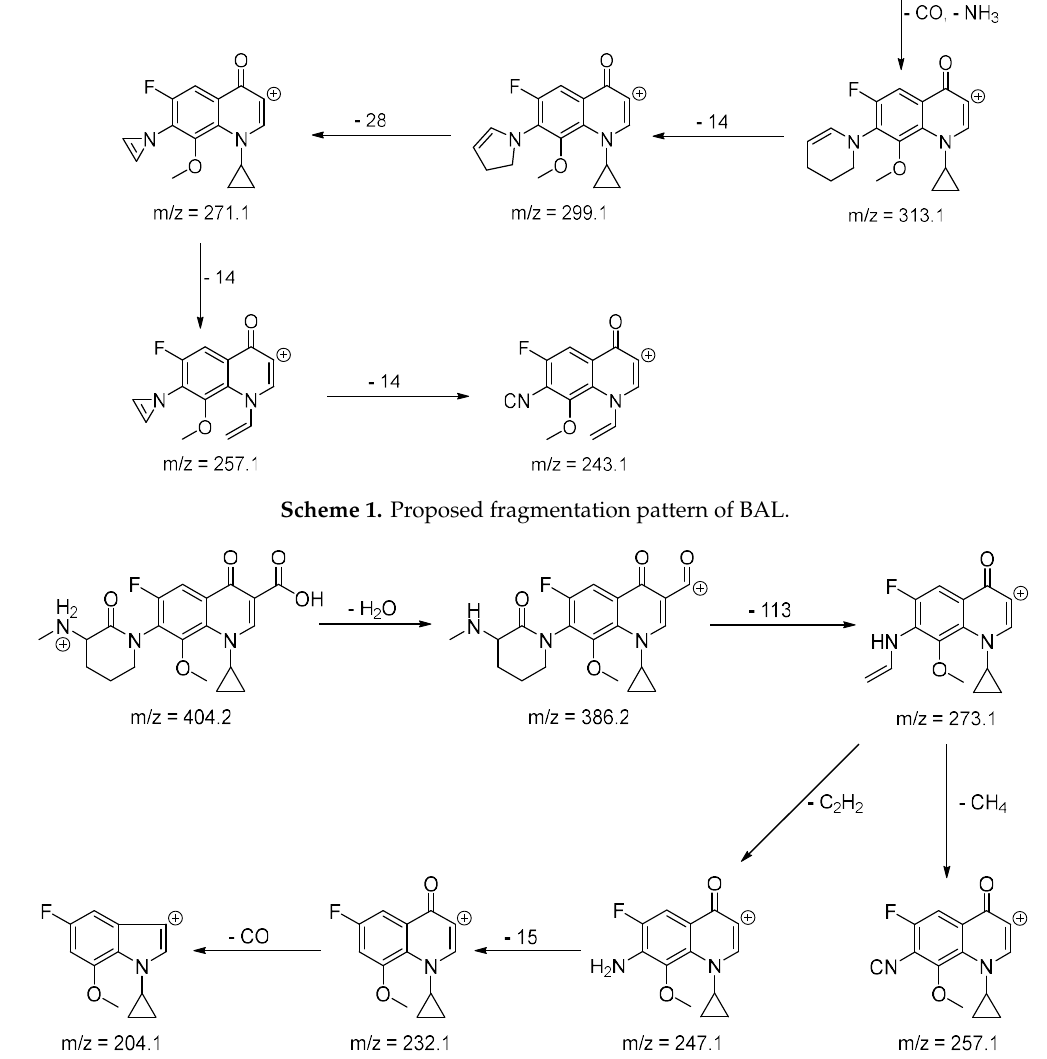
Scheme 2. Proposed fragmentation pattern of BP-1 .